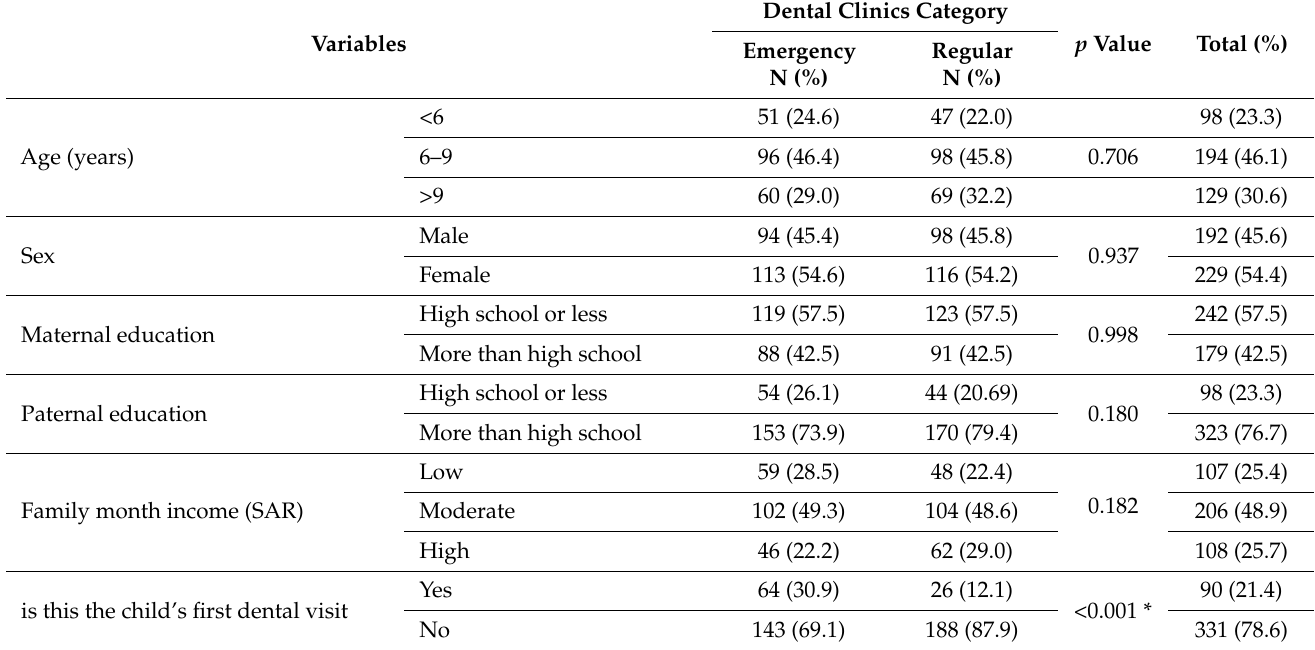
Table 1. Distribution of cases and controls according to their sociodemographic data, DMFT/dmft, and group (visiting emergency versus regular clinics); N =